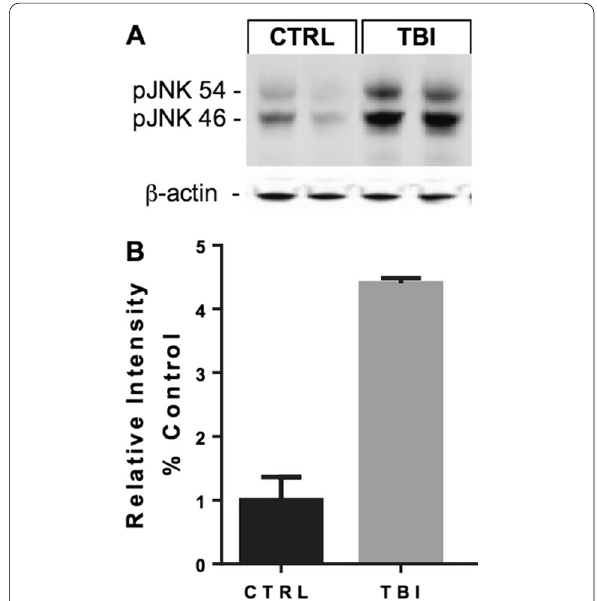
Fig. 6 JNK activity is elevated 72 h after TBI. a Western blot data were probed for phosphorylated JNK and beta actin. b A fourfold increase in pJNK was seen in TBI samples